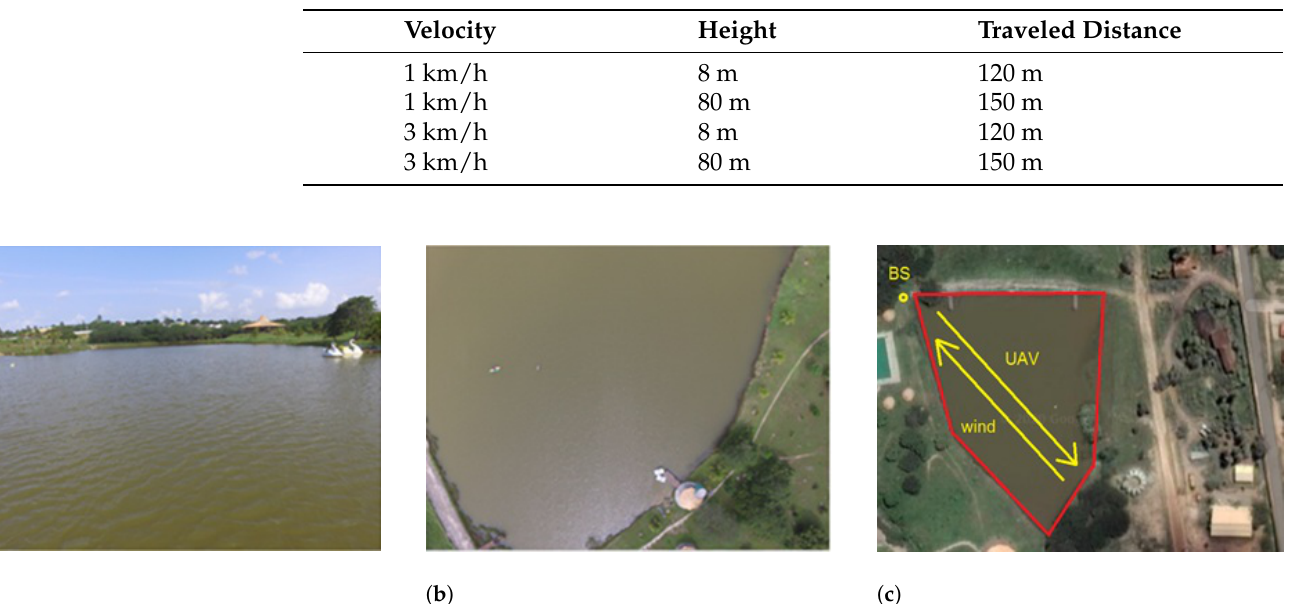
Figure 3. Lake photos taken at different heights. ( a ) Photo taken with UAV over the lake at a height of 8 m. ( b ) Photo taken with UAV over the lake at a height of 80 m. ( c ) Showing the base station (BS) and the lake